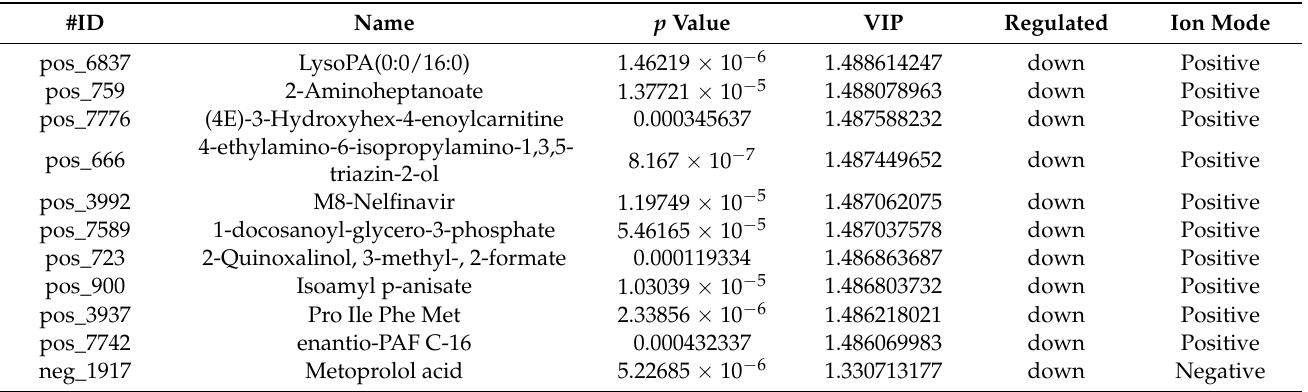
Figure 4. Screening results of differential metabolites. ( A , B ) Histogram of differential multiples of metabolites in positive and negative ion mode. The label of each column indicates the metabolite name, red for up-regulation, green for down-regulation, and column length for logFC. The figure shows the top 10 substances in logFC order. ( C , D ) Clustering heat map of differential metabolites in positive and negative ion mode. X-axis is each sample, Y-axis is the quantitative value of metabolite z-score standardized after hierarchical clustering, and the color bar on the top distinguishes different groups. ( E , F ) Volcano map of differential metabolites in positive and negative ion mode. Each point on the volcano plot represents a metabolite, the X-axis represents the fold change (take the logarithm base 2), and the Y-axis represents the p value of the t -test (take the logarithm base 10). Blue dots in the figure represent downregulated differentially expressed metabolites, red dots represent upregulated differentially expressed metabolites, and gray represents metabolites detected but not significantly different. In addition, the first five qualitative metabolites were selected and labeled in the figure after sorting by p value. Table 1. The top 10 differential metabolites in the positive and negative ion modes, respectively, in descending order of VIP value. VIP is the VIP value of OPLS-DA model, p value is the p value of t